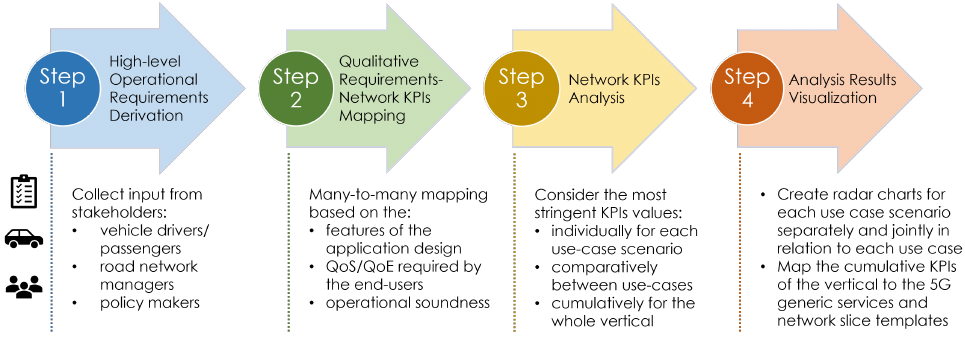
Figure 1. Overview of the proposed